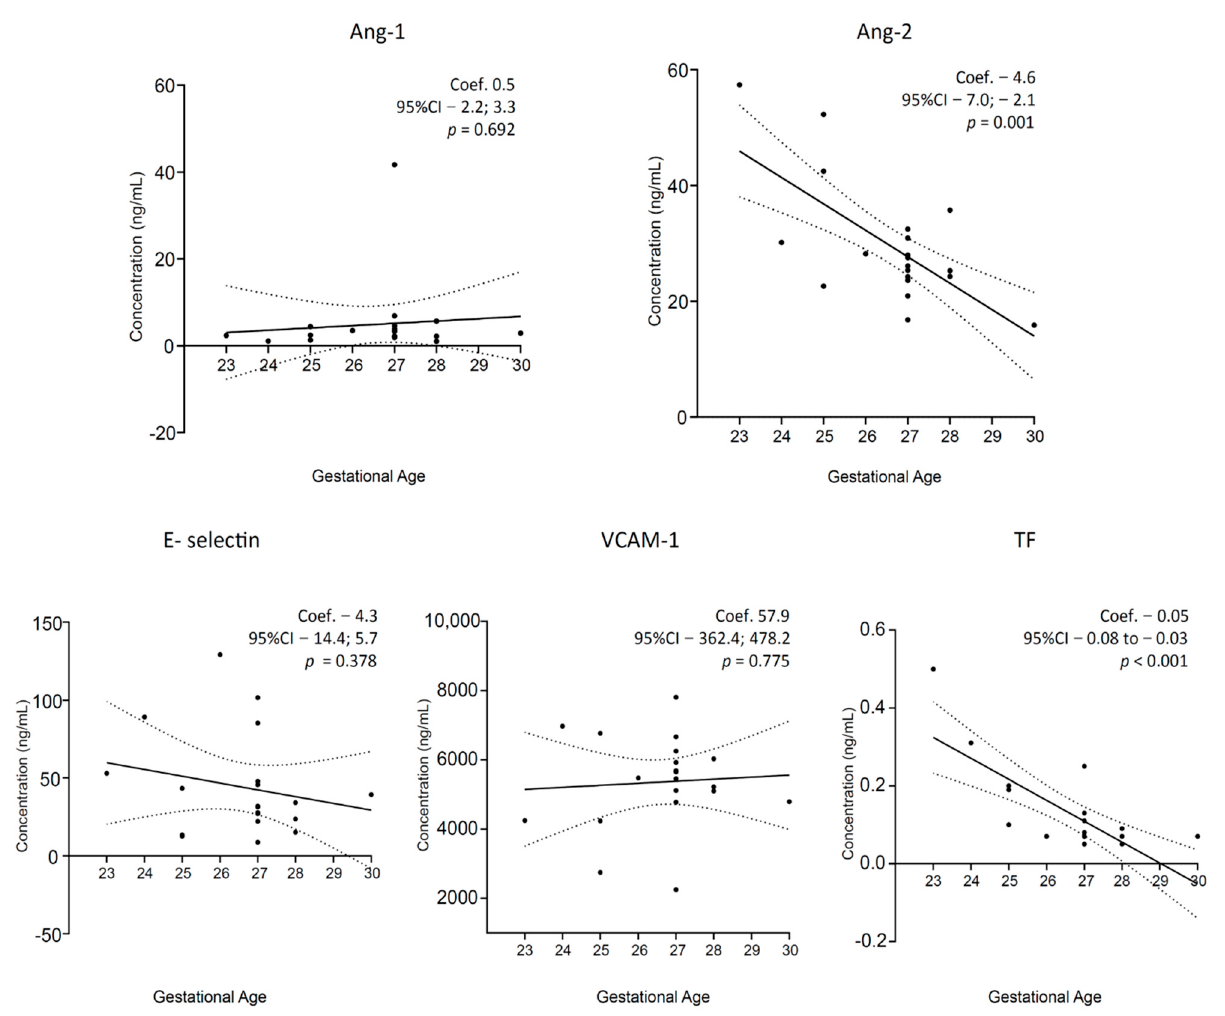
Figure 3. Soluble endothelial markers and gestational age in very preterm infants. Scatterplots of soluble markers at T1 are represented. A linear regression model was applied between gestational age and soluble markers. Concentrations are expressed as ng/mL. Coef, linear regression coefficient; p, p -values; CI, confident interval; T1, 1st day of life sample; Ang-1 and -2, angiopoietin-1 and -2; VCAM-1, vascular adhesion molecule-1; TF, tissue